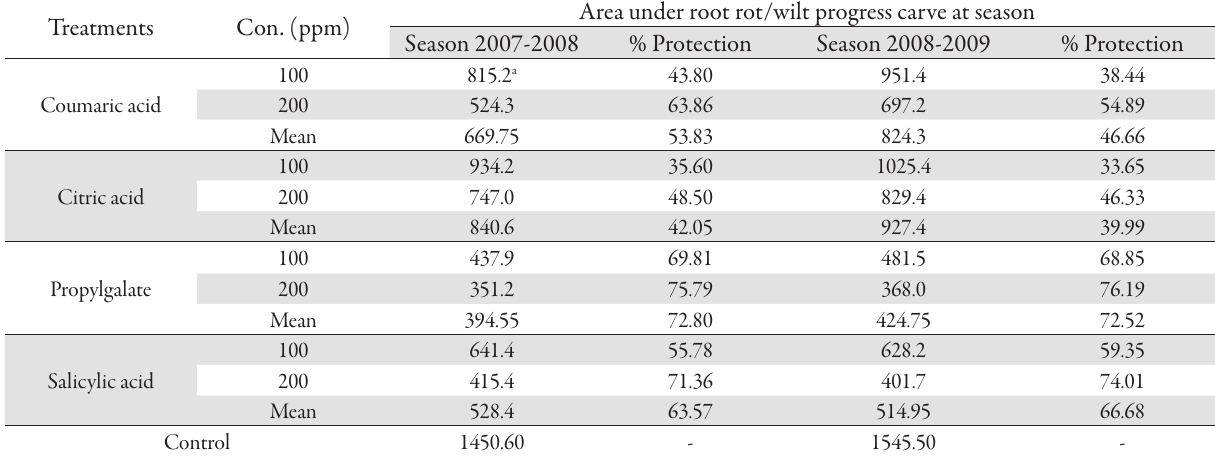
Tab. 7. Effect of pepper seedling soaking in antioxidant solutions on area under root rot/wilt progress curve during 2007-2008 and 2008-2009 growing seasons under field condition at New Valley, Egypt